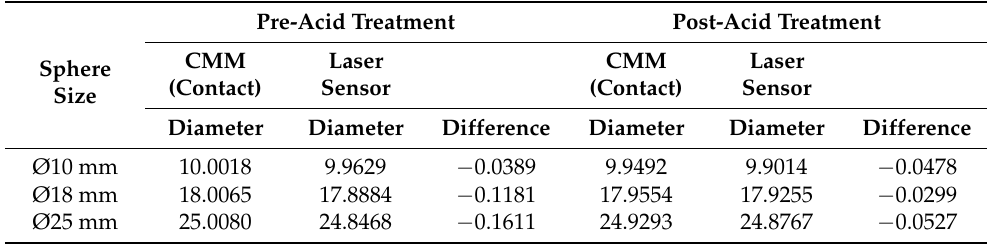
Table 1. Comparison of contact and noncontact measurements (mm) regarding diameter pre- and post-acid treatment.